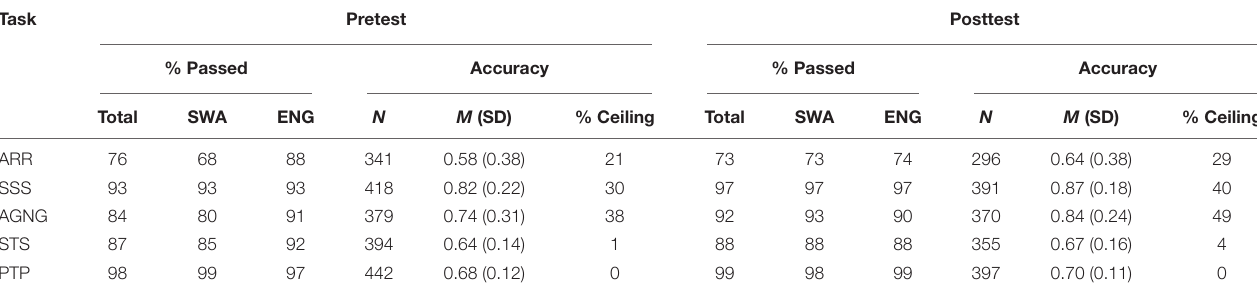
TABLE 3 | Completion rates and descriptive statistics for individual executive function